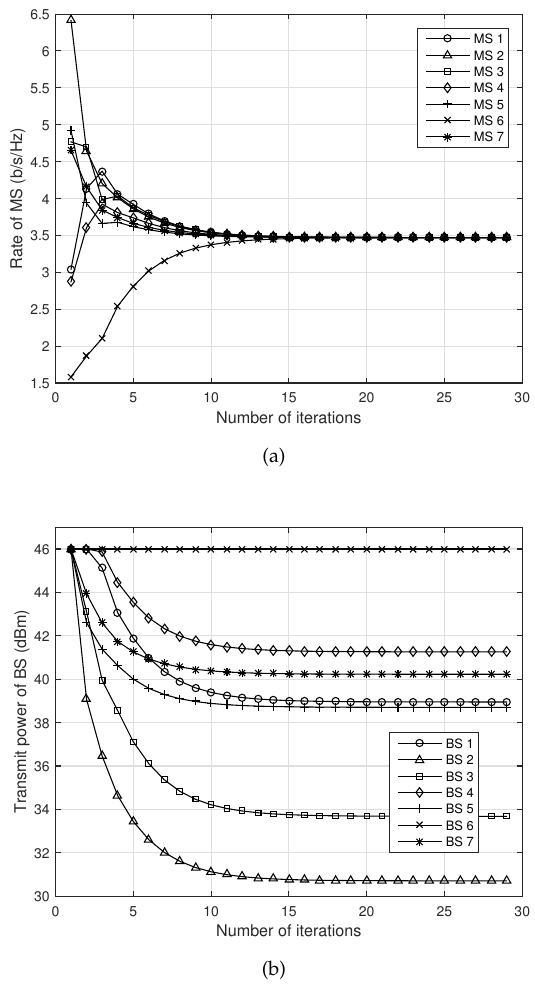
Figure 4. ( a ) Rate of MS; and ( b ) transmit power of BS vs. number of